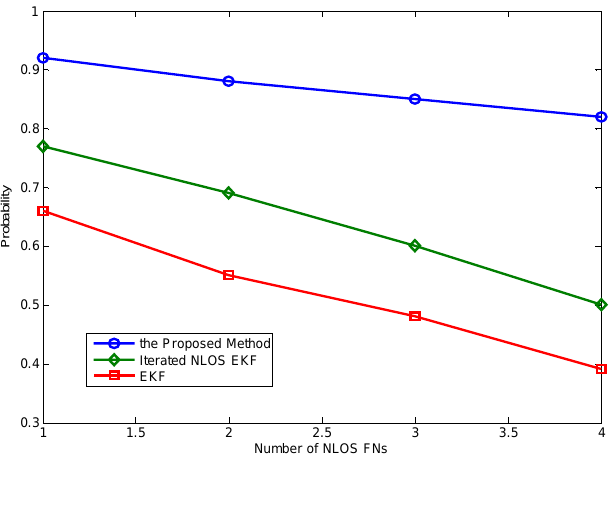
Figure 7. Impact of the number of NLOS FNs on the location accuracy in the bad node